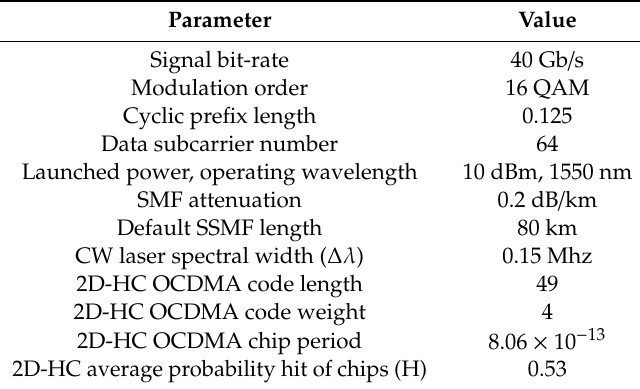
Table 2. Analytical system parameters.